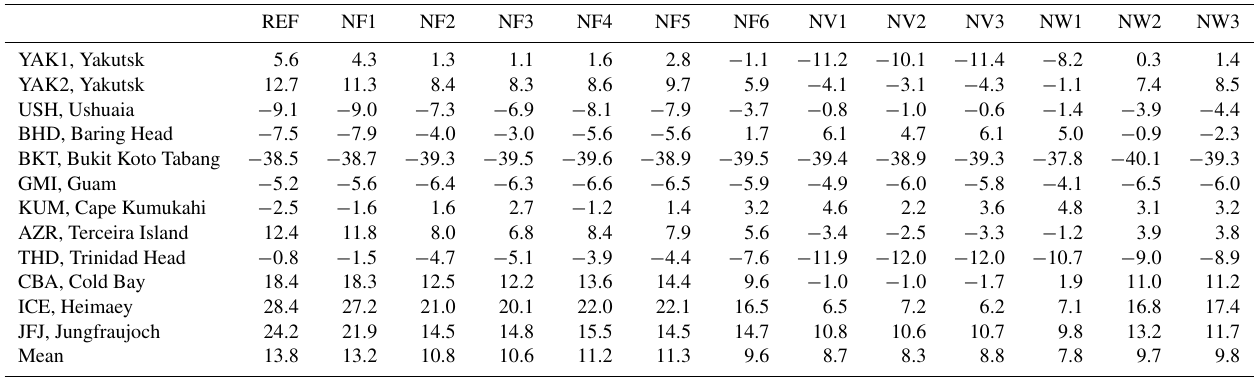
Table 2. Bias of modelled methane (ppb) at independent surface validation stations. The mean value is the mean of absolute bias value at all stations listed. Settings of FLEXPART CTM simulations are given in Table 1. Station locations are shown in Fig. 1 and coordinates are given in Table S1.